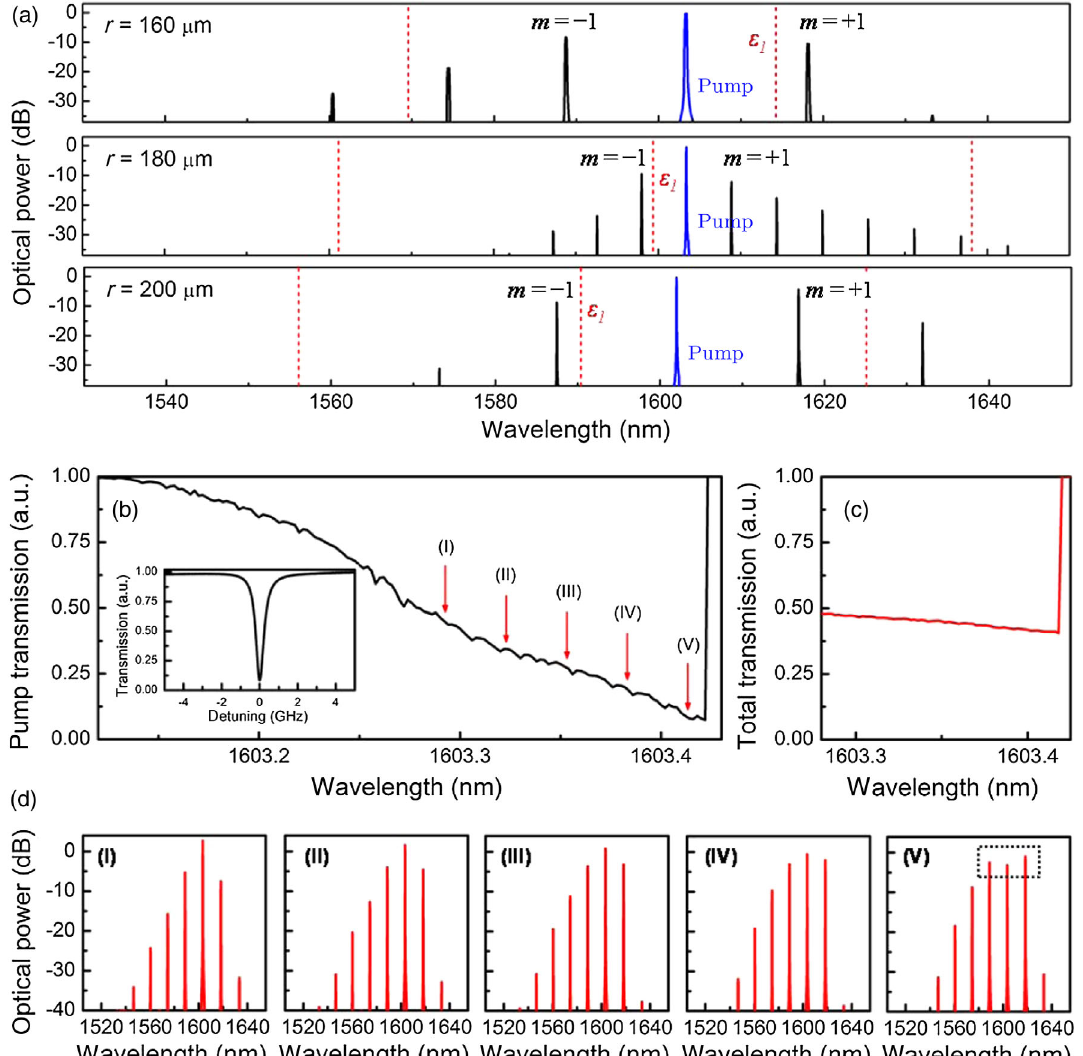
FIG. 2. (a) Turing rolls generated from ring resonators with different radii. Even though the GVD of the ring resonators differ by less than 2 fs 2 = mm, the TM 11 -TM 21 mode hybridization positions (red dashed lines) with respect to the pump (blue lines) shift because of the change in the ring radii, resulting in abrupt dispersion variations locally and very different spontaneous Turing patterns. The Turing- roll repetition rates are 1.72 THz ( 12 × FSR) for the 160 μ m radius ring, 0.64 THz ( 5 × FSR) for the 180 μ m radius ring, and 1.72 THz ( 15 × FSR) for the 200 μ m radius ring. (b) Pump-cavity transmission as a function of the pump wavelength, labeling the detunings where different Turing-roll stages are generated. Inset: The cold resonance of the pump mode, measuring a loaded Lorentzian linewidth of 500 MHz and a loaded quality factor of 3 . 7 × 10 5 . (c) Total cavity transmission as a function of the pump wavelength in the range where the Turing roll is generated. Compared to the pump-cavity transmission, the total cavity transmission shows a less apparent decrease as the pump is tuned into the resonance, confirming an efficient power conversion from the pump to the generated Turing lines. (d) Example Turing-roll spectra at different stages. At stage V, even a highly depleted pump close to the resonance is observed in the measurement, illustrated in the dashed